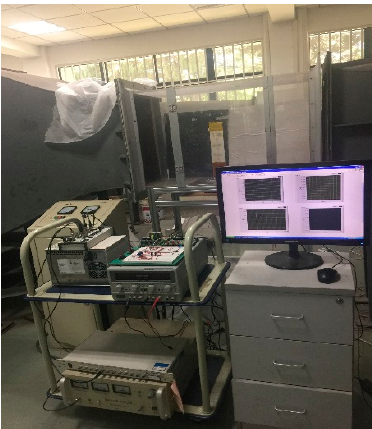
Figure 10. Experimental equipment of the wind tunnel test.